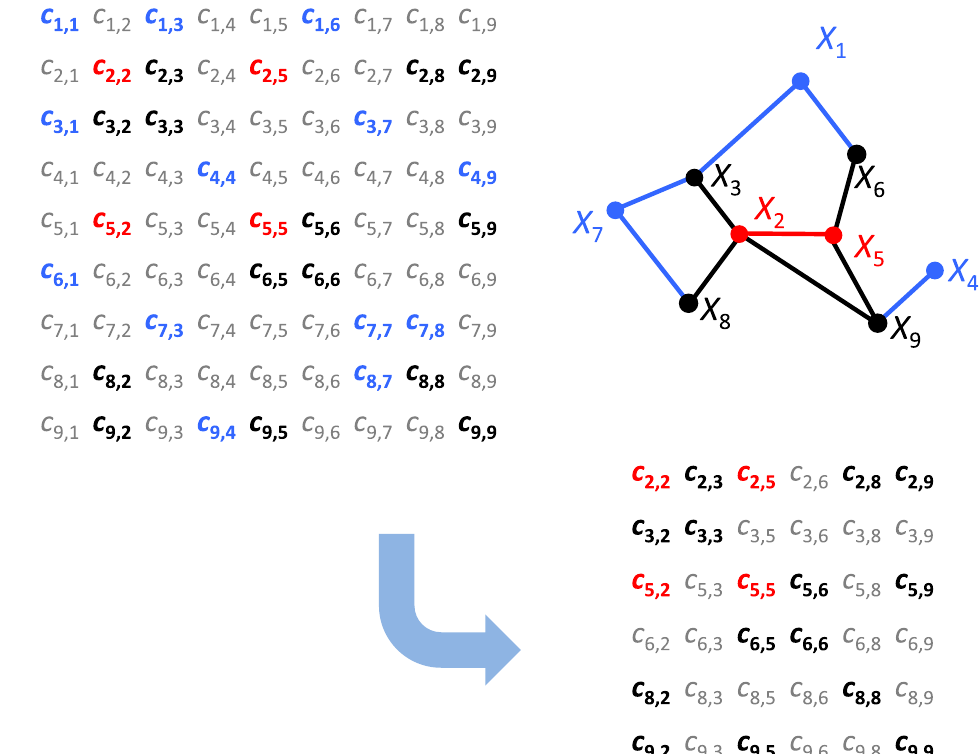
Figure 6. Local partial correlation scheme: we calculate the LPC for pair X set of nodes X , X , X , X (black nodes/edges). X 3 6 8 9 with the red nodes. Thus the inverse method is applied exclusively to the correlation sub-matrix formed only by the genes X X . In correlation matrices the gray entries are statistically non-significant empirical 9